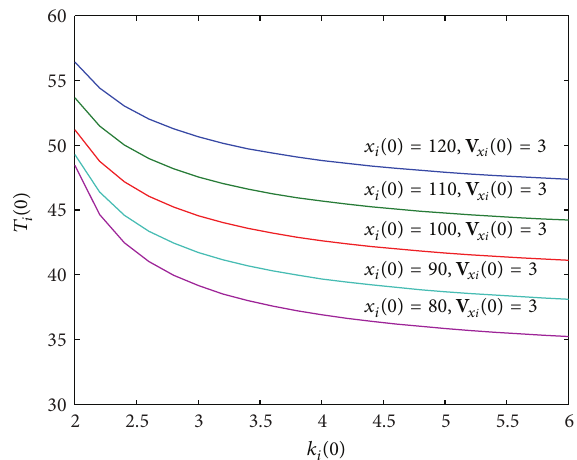
Figure 4: The mapping relation between proportional guidance coefficient and time-to-go.